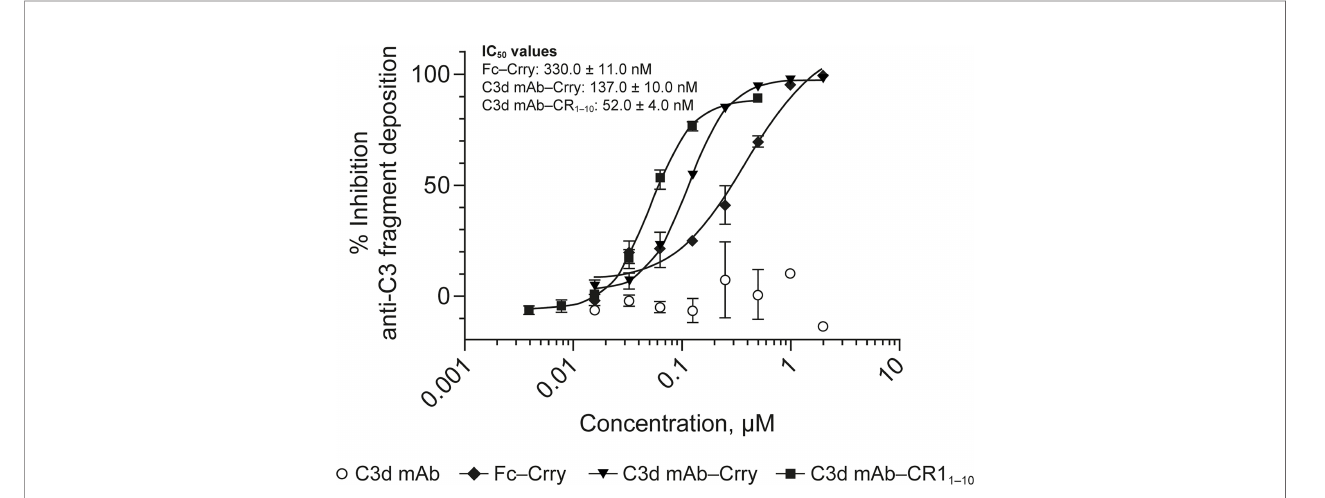
FIGURE 6 | Dose response curves for mouse surrogate C3d mAb − Crry, Fc-Crry, C3d mAb-CR1 1-10 and parent C3d mAb, 3d8b, in murine complement activation assays. Complement inhibitory activity is shown for C3d mAb – Crry (closed triangles), Fc-Crry (closed diamonds), mAb-CR1 1-10 (closed squares) and C3d mAb (open circles) in zymosan assays using mouse serum. Replicate data are shown as mean values plus SEM. IC 50 values are provided for C3d mAb − Crry, Fc-Crry, and C3d mAb-CR1 1-10. mAb, monoclonal antibody; SEM, standard error of the mean.